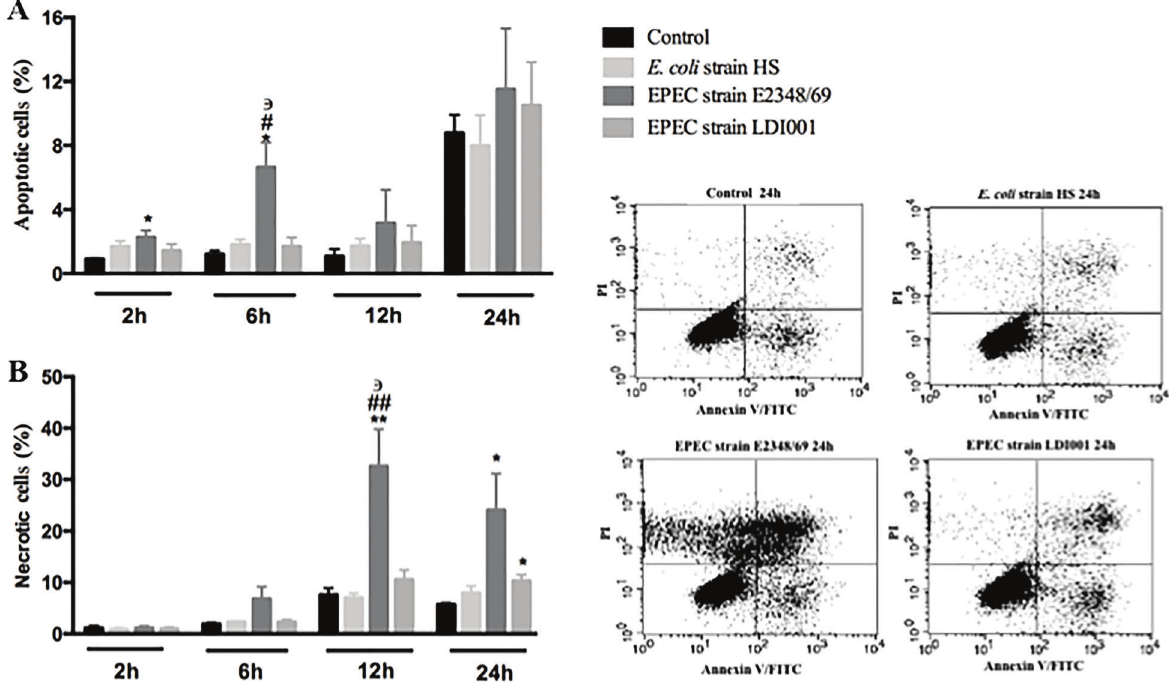
Figure 2. Kinetic analysis of apoptosis ( A ) and necrosis ( B ) rates on intestinal epithelial IEC-6 cell induced by enteropathogenic Escherichia coli (EPEC) strains E2348/69 and LDI001 and commensal E. coli strain HS (inocula, 10 6 CFU per mL). Data are reported as mean ± SE of three independent experiments. *P o 0.05 and **P o 0.01 vs uninfected control; # P o 0.05 and ## P o 0.01 vs E. coli strain HS; E P o 0.05 vs EPEC strain LDI001 (ANOVA followed by Bonferroni ’ s